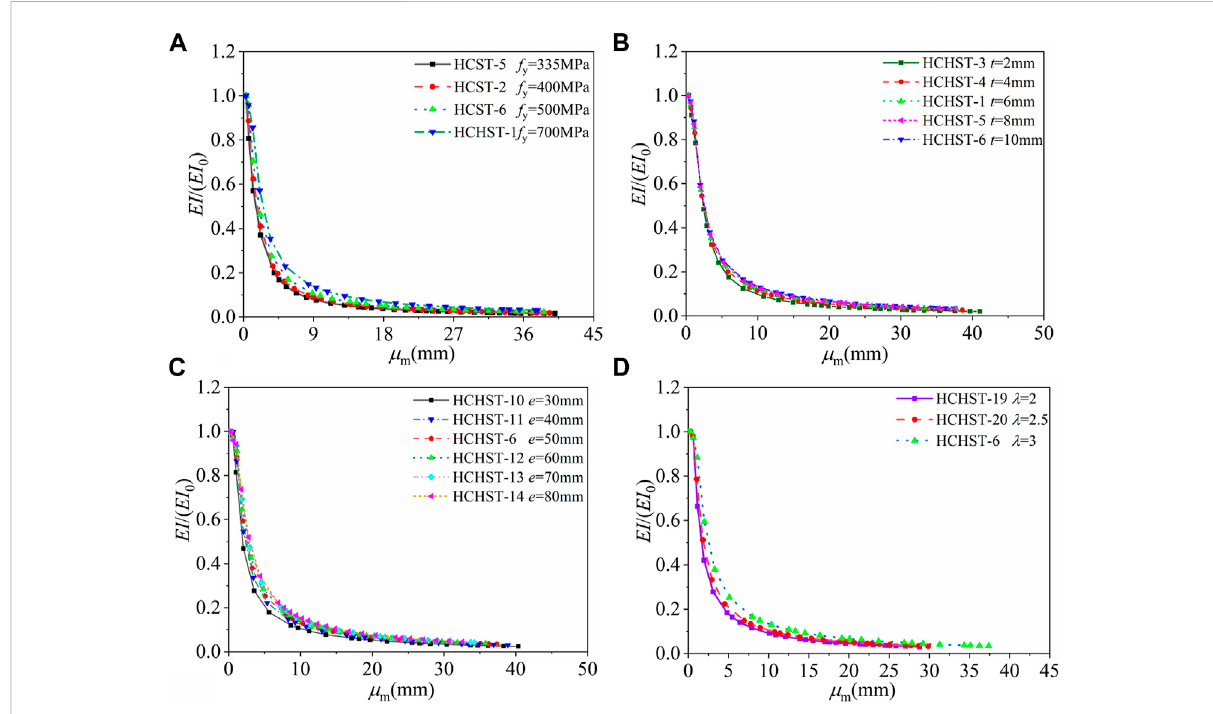
FIGURE 10 Stiffness degradation curves with different parameters: (A) Stiffness degradation curves with different f y ; (B) Stiffness degradation curves with different t ; (C) Stiffness degradation curves with different e ; (D) Stiffness degradation curves with different λ